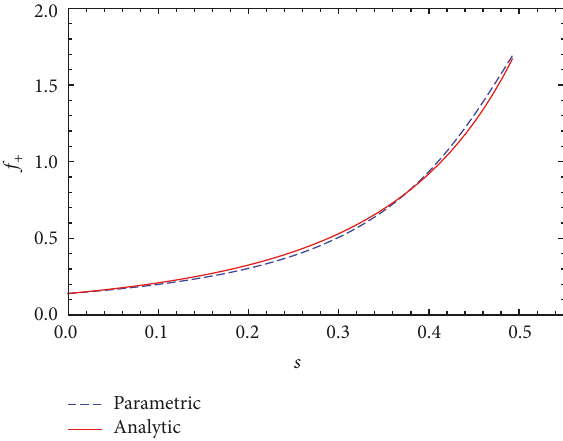
Figure2:Analyticsolutionsof 𝑓 + (thicksolidcurve)comparedwith the parametric results (dashed curve), with definition 𝑠 = 𝑞 2 /𝑀 2 퐵 +